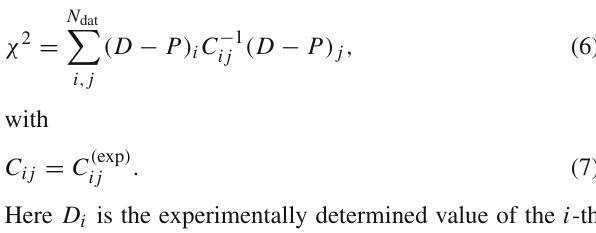
trained data is used for the minimization while the validation χ 2 is utilized for early